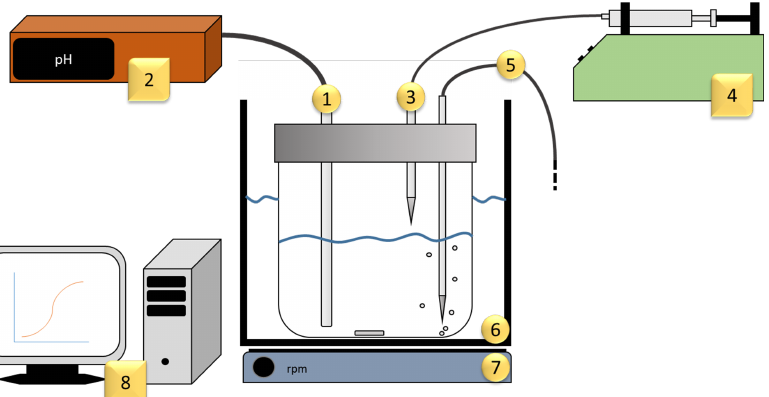
Figure 1. Schematic layout of the system for potentiometric titration (1: pH probe, 2: pH meter, 3: capillary for dosing, 4: dosing pump, 5: argon inlet, 6: thermostat bath, 7: magnetic stirrer, 8: PC for data